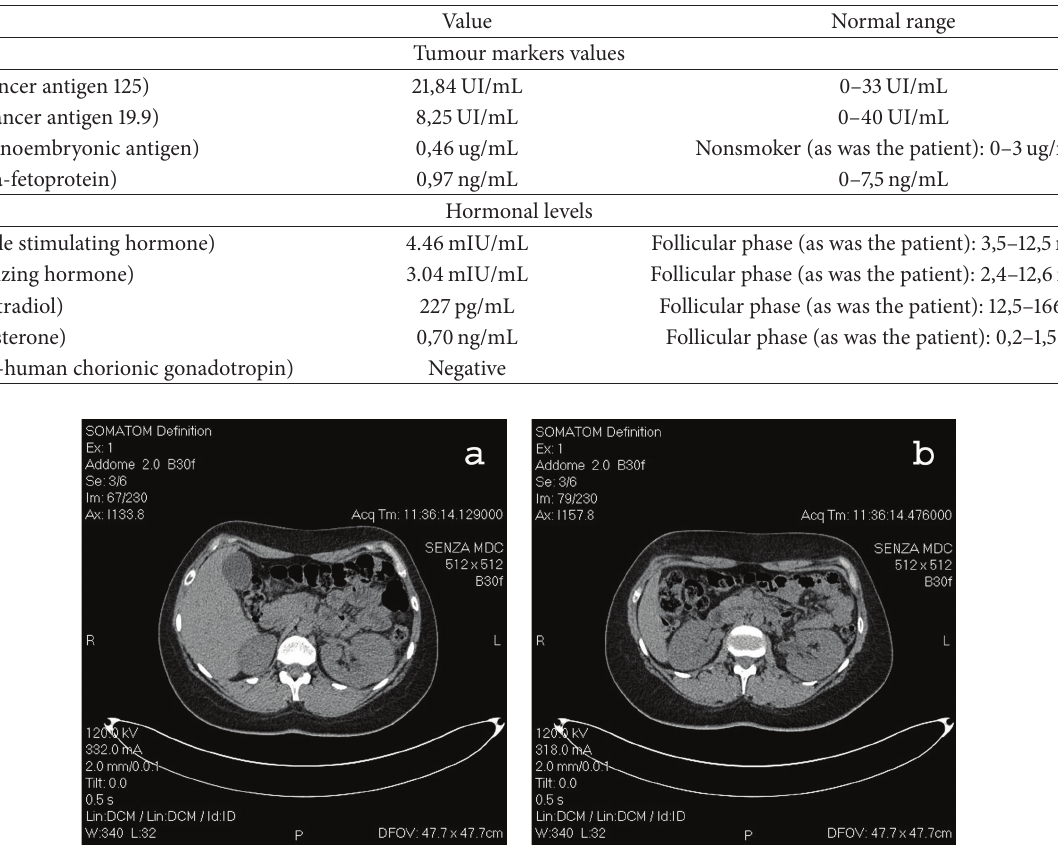
Figure 2: Uro-CT: (a) and (b) confirmation of the first degree hydronephrosis of the left